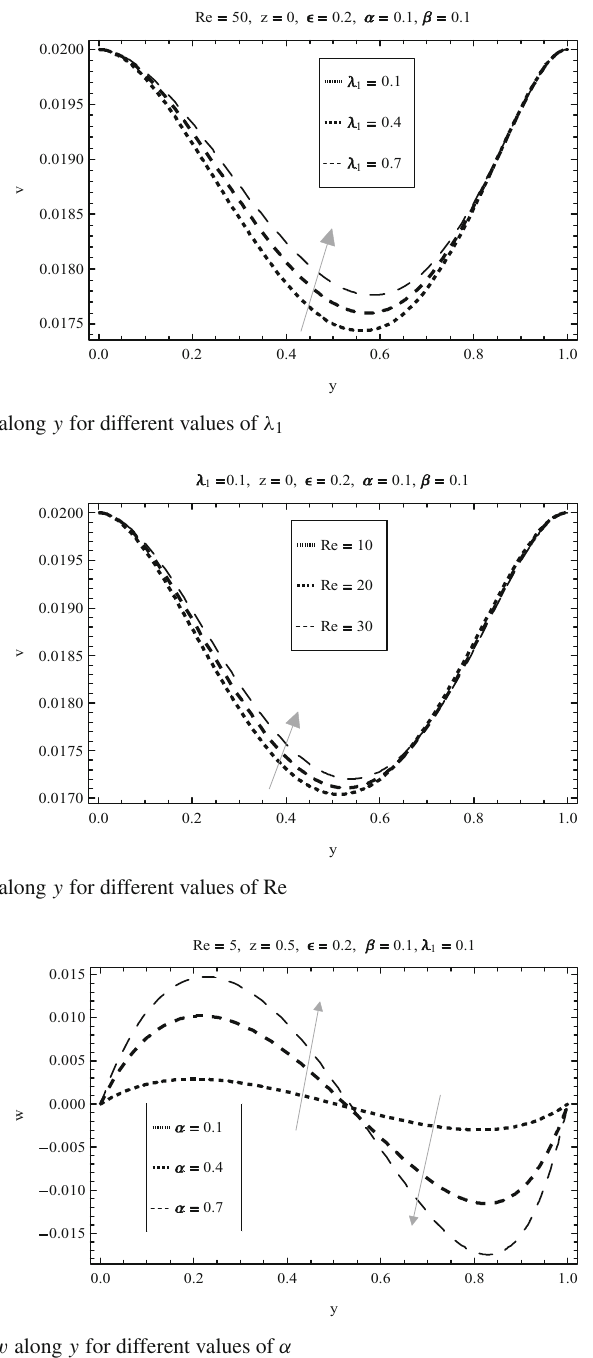
neighbourhood of the lower plate (stationary plate) is sufficient to overcome the adverse pressure gradient, and hence there is forward flow. On the contrary, due to the periodic suction at the upper plate (moving plate), the dragging effect of the faster layer exerted on the fluid particles will be reduced, and hence this dragging effect is insufficient to overcome the adverse pressure gradient and there is backflow. From Fig. 10, it is shown that the velocity component w increases with an increase of α in forward flow, but decreases with an increase of α in backward flow. It is obvious from Figs. 11, 12 and 13 that the velocity component w decreases with an increase of β , λ 1 or Re in forward flow; however, a reverse effect is seen in the backward